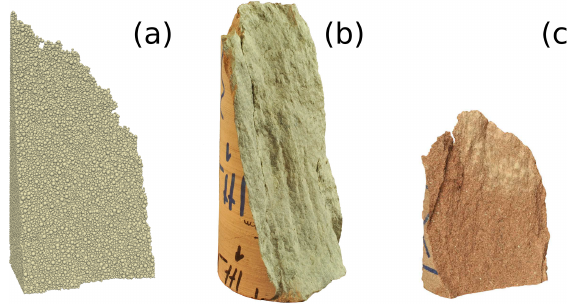
Figure 4. Types of fracture surfaces studied in this work: (a) nu- merical (DEM) model, (b) limestone fragment generated in triaxial deformation experiment, (c) sandstone fragment generated in uni- axial deformation